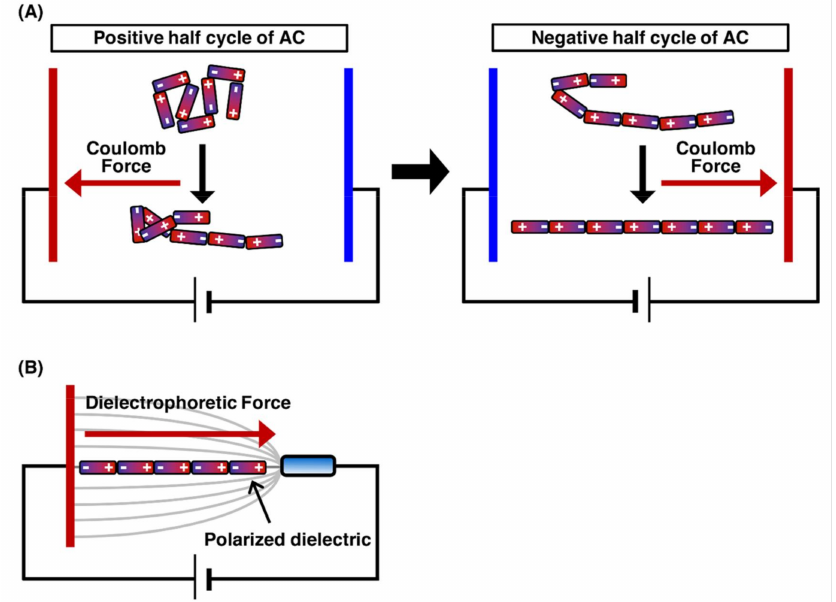
Figure 2. Outline of the stretching of the DNA molecule by orientation manipulation. The charge is induced on the single DNA molecule by the electric field. The Coulomb forces are exerted on the induced charges, and then, the DNA molecule is stretched by the Coulomb forces. ( A ) The stretching process for DNA molecule by the application of AC electric field. ( B ) The stretching of DNA molecule by orientational